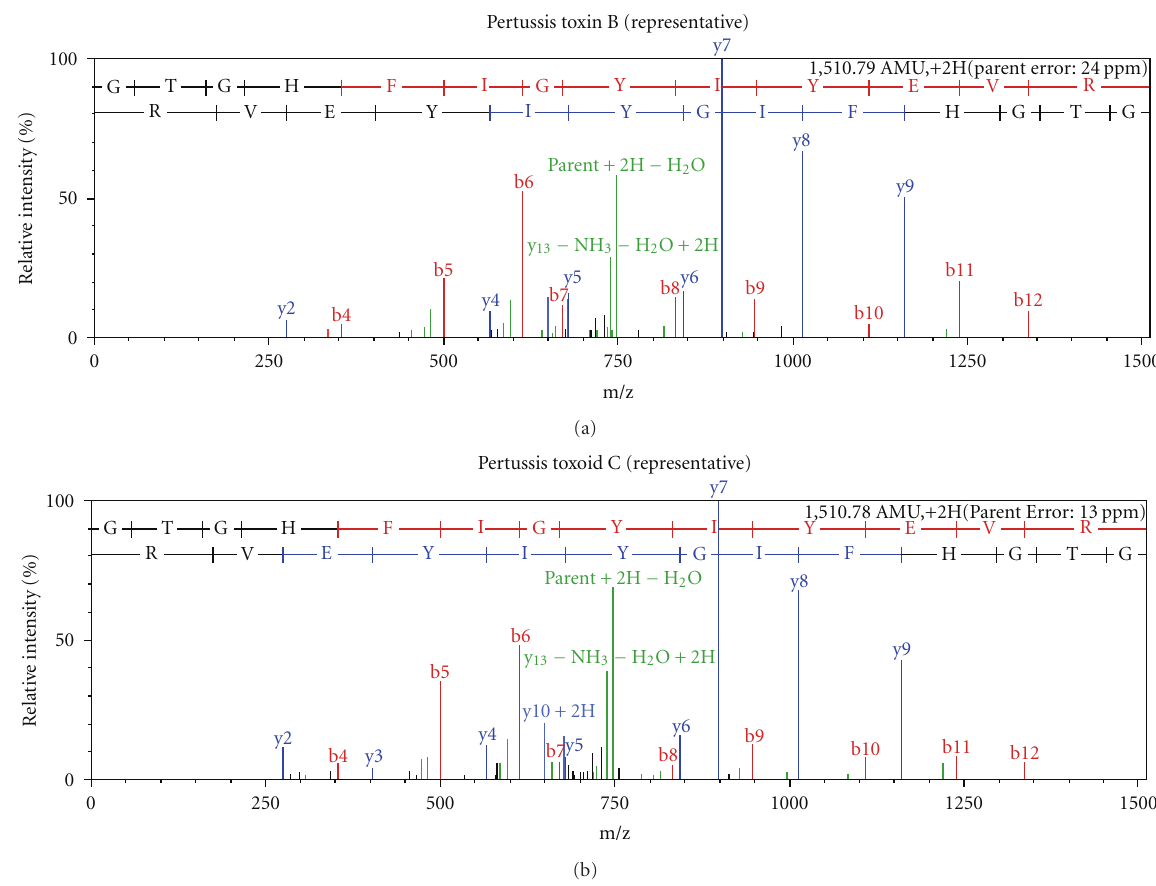
Figure 1: MS/MS spectra illustrating similar fragmentation profiles of Subunit 1 peptide GTGHFIGIYEVR from representative pertussis toxin (B) and pertussis toxoid (C). Nano Liquid Chromatography MS/MS were performed using the LTQ-Orbitrap on tryptic peptides obtained from pertussis toxin B and pertussis toxoid C. The MS/MS data was searched against the NCBI database and the peptide spectrum was analyzed [comparing relative peak intensity (0–100%) versus mass/charge (0 to 1500)] using the Sca ff old software. The red and blue lines represent y- and b-ion distribution peaks, respectively.